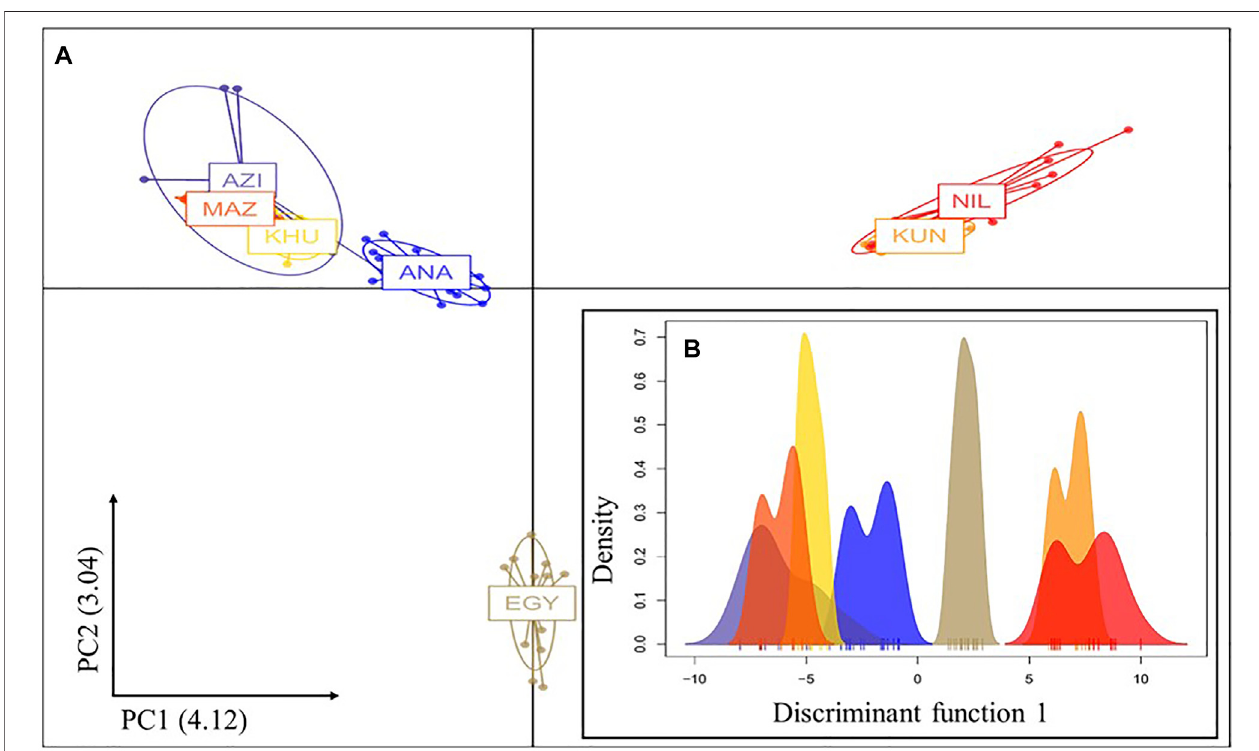
FIGURE 1 | A two fi rst PCs and B fi rst PC only of the DAPC analysis of the water buffalo populations studied. Clusters are indicated by different colors (blue, gray, and green), and populations are identi fi ed by their abbreviations AZI, KHU, MAZ, ANA, EGY, KUN, and NIL.